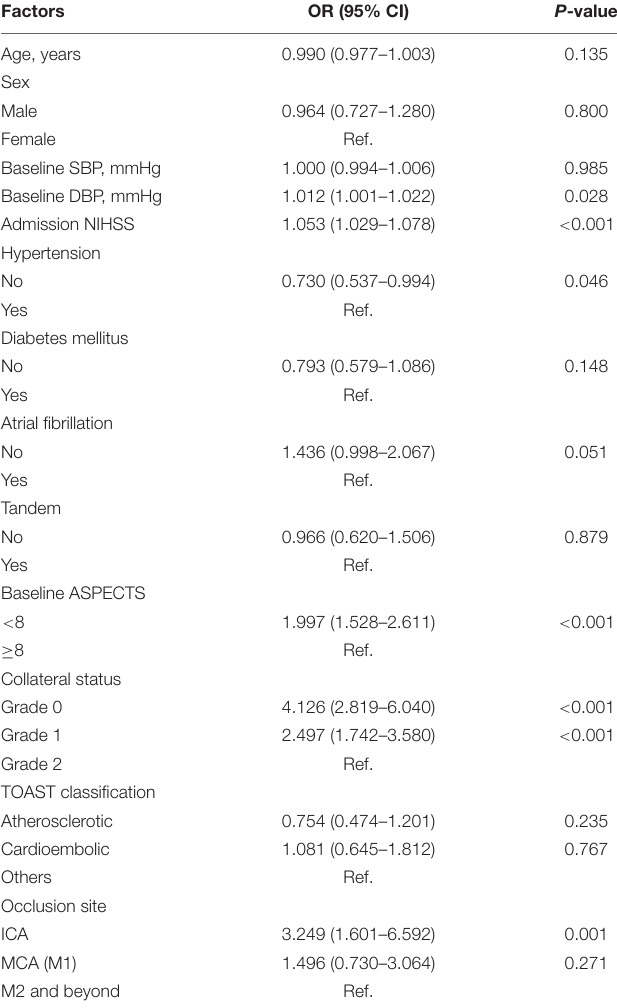
TABLE 2 | Ordered logistic regression analysis of factors affecting the grading of brain edema after treatment in patients with acute ischemic stroke.